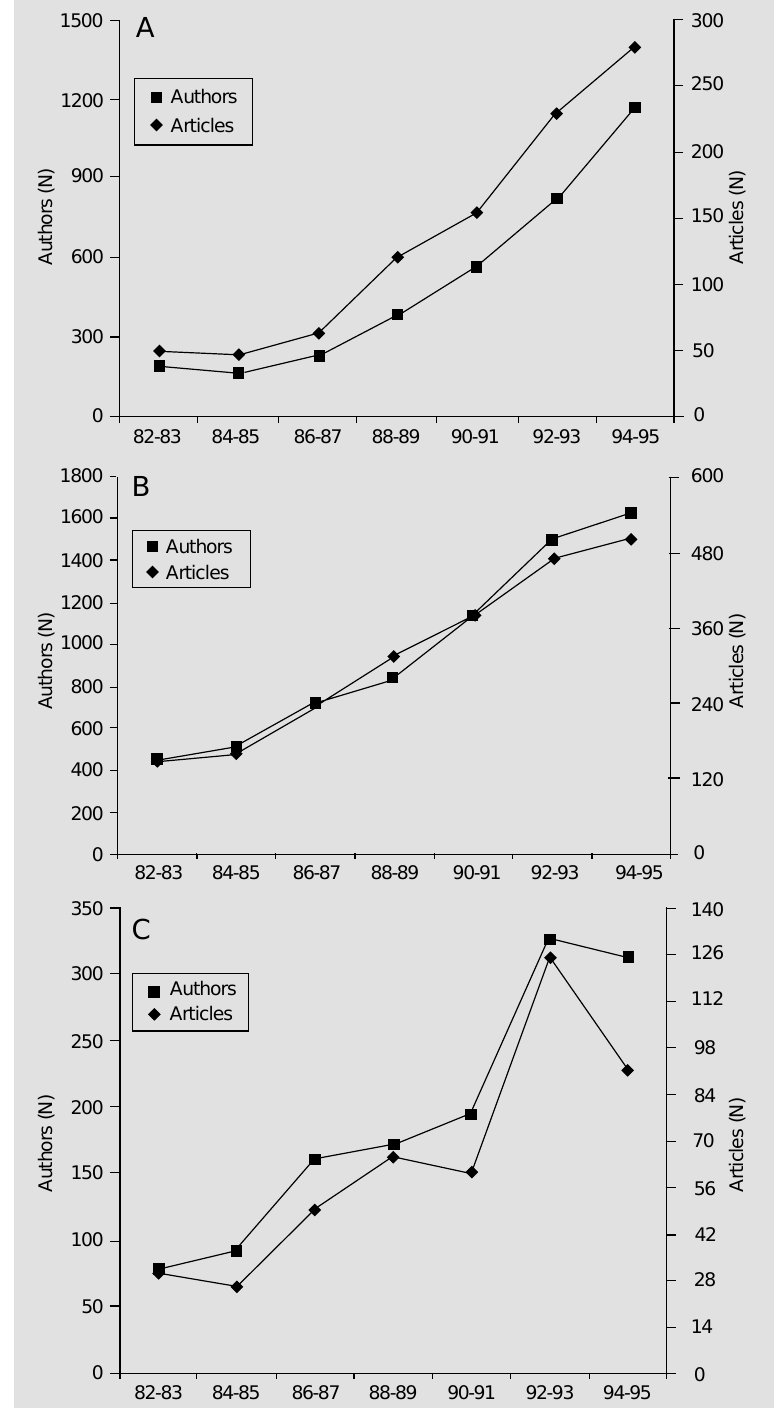
Figure 1 - Article output and trends for author numbers. Ordinates: Left - number of authors; right - number of articles. Abscissa: Two-year periods from 82-83 to 94-95 in which author and article numbers were grouped for each research area analyzed: cancer (A), cardiovascu- lar (B) and malaria (C). Data from both ISI and